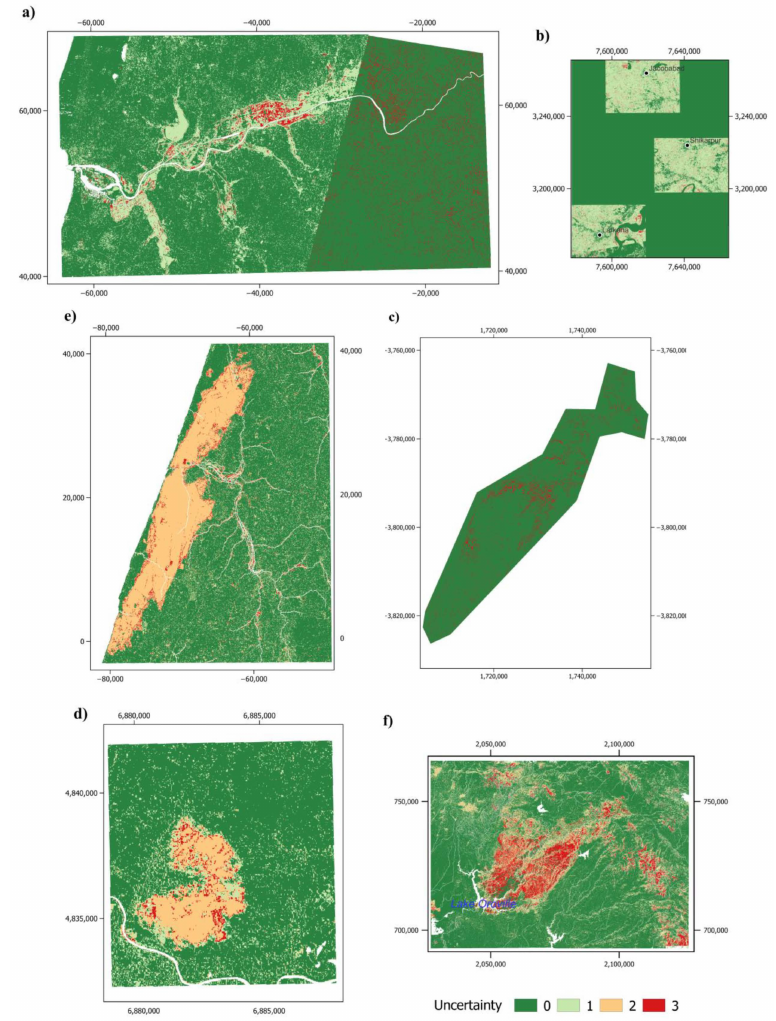
Figure 15. Uncertainty maps for ( a ) the Mondego Flood; ( b ) the Sindh Province floods; ( c ) the Rich- mond Flood; ( d ) the Monte Pisano Fire; ( e ) the Leiria National Forest fire; ( f ) the North Complex fire; with ( a , b , d – f ) being obtained from the fusion dataset and ( c ) being obtained from the SAR